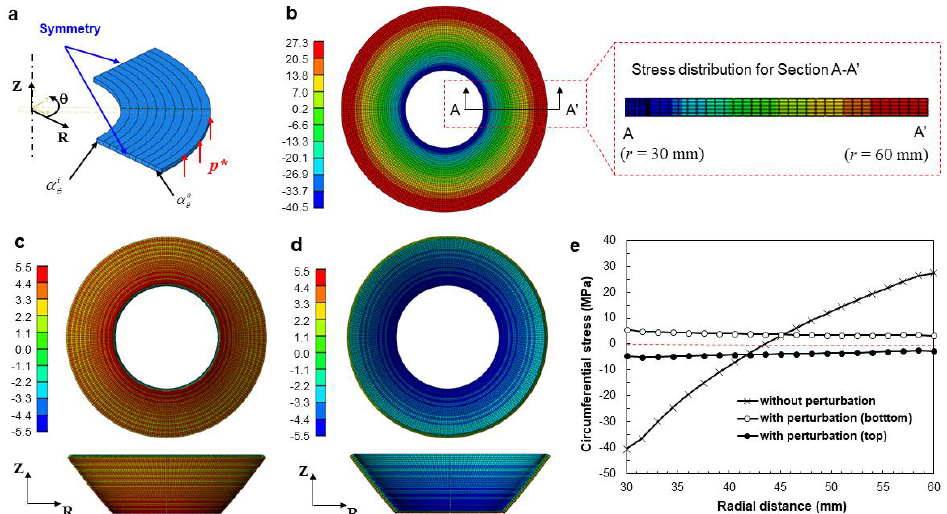
Figure 7. Finite element (FE) analysis results for the residual circumferential stress (unit: MPa): ( a ) analysis model with boundary conditions; ( b ) without perturbation; ( c ) with perturbation (bottom side, the bottom and front views); ( d ) with perturbation (top side, the top and sectional views); ( e ) comparison of the circumferential stress along the path A–A’. Table 4. Directional thermal expansion coefficients and the relevant simulation